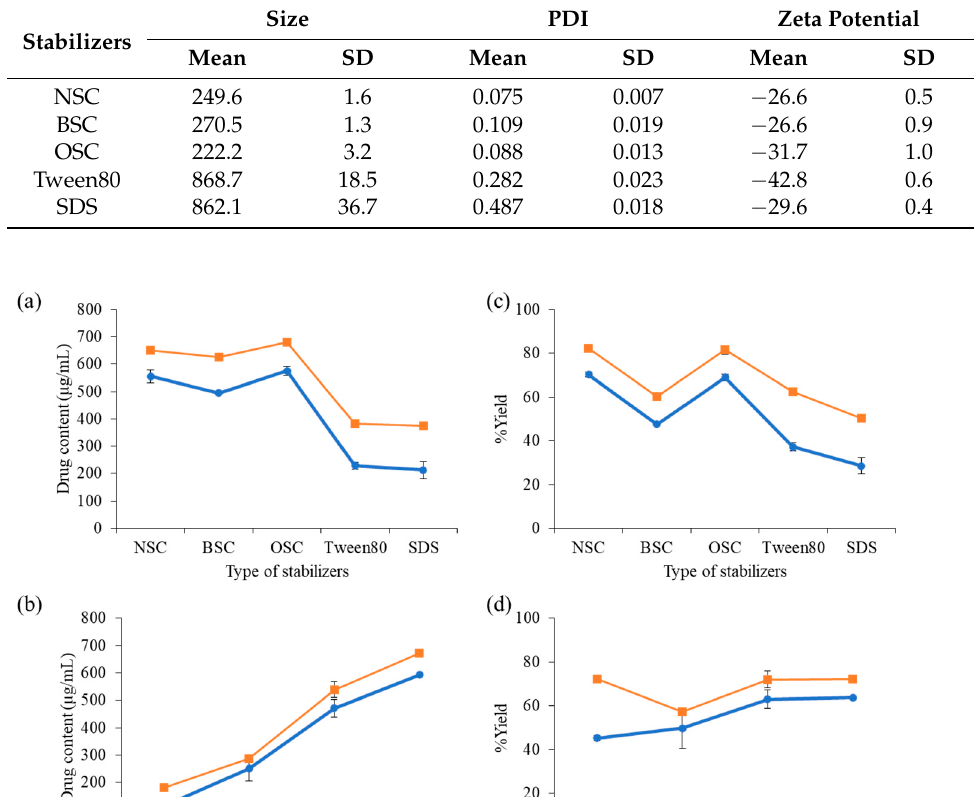
Table 1. The effect of stabilizer types on the particle size, polydispersity index (PDI), and zeta potential of 3nAGN. The means and standard deviations of triplicate experiments are used to represent the data. Table 2. The particle size, polydispersity index (PDI), and zeta potential of 3nAGN prepared with different ratios of 3nAG:NSC. All data represent the mean ± standard deviation (n = 3). Stabilizers